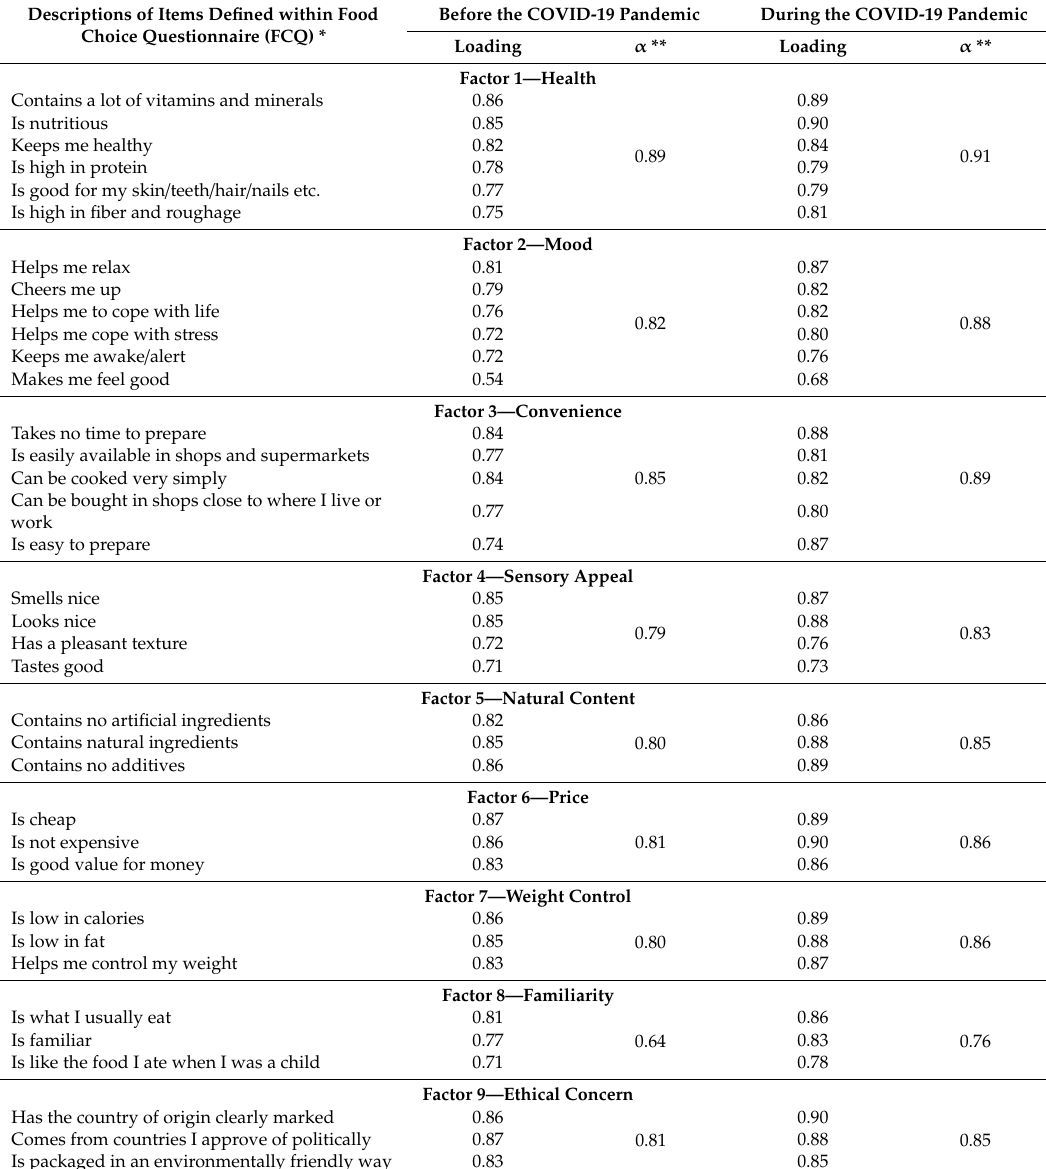
Table 4. The results of the loading and Cronbach’s alpha coe ffi cient for the applied Food Choice Questionnaire (FCQ) for the period before and during the COVID-19 pandemic for the sample of male adolescents studied within the PLACE-19 Study ( n =